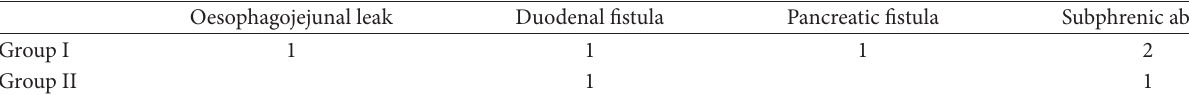
Table 3: Complications after total gastrectomy.